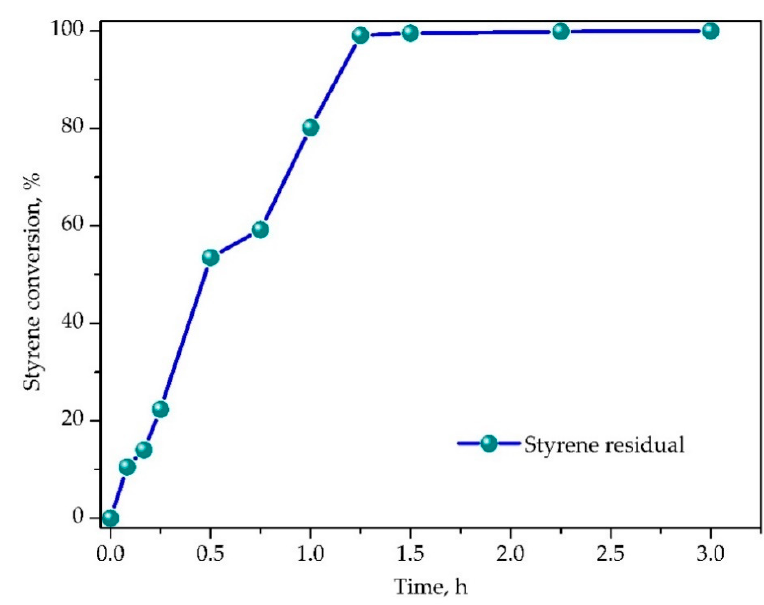
Figure 1. Conversion of styrene versus time in experiment LEBA15.